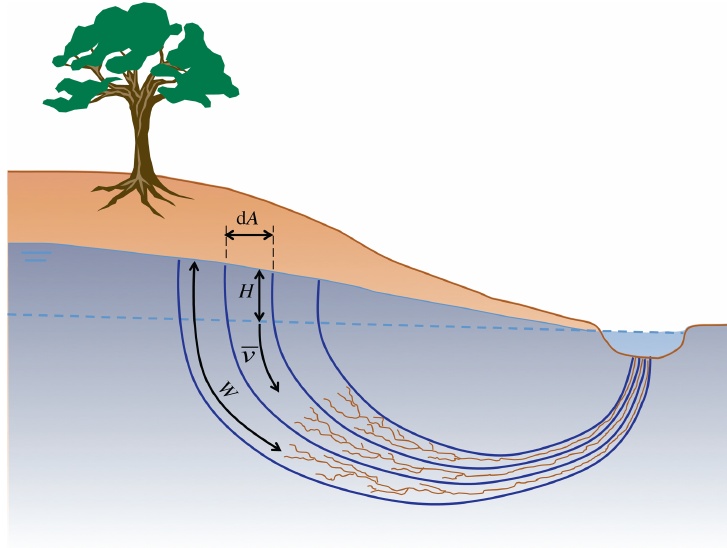
Figure 2. Conceptual sketch of an unconfined phreatic groundwater body draining towards a surface drain. H is the head of the phreatic water table with respect to the nearest open